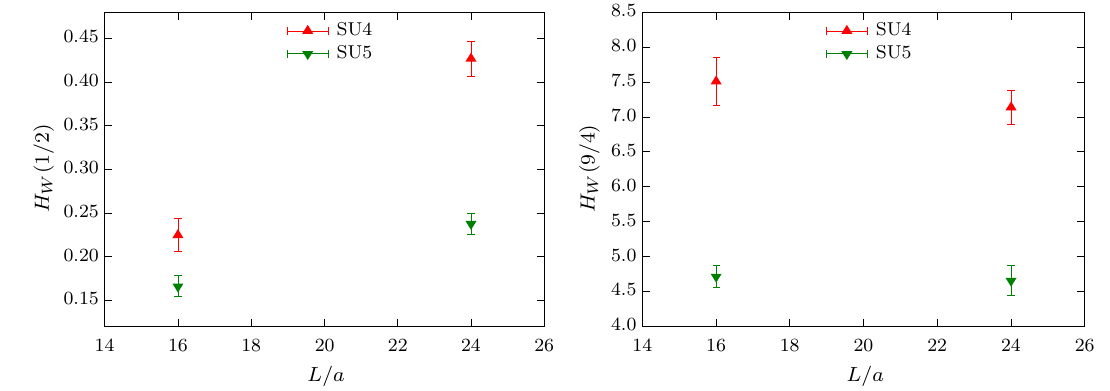
Fig. 10 Finite volume checks for H W . On the left at c = 1 / 2, and on the right at c = 9 / 4. Notice that at the smaller c the finite volume corrections are very significant